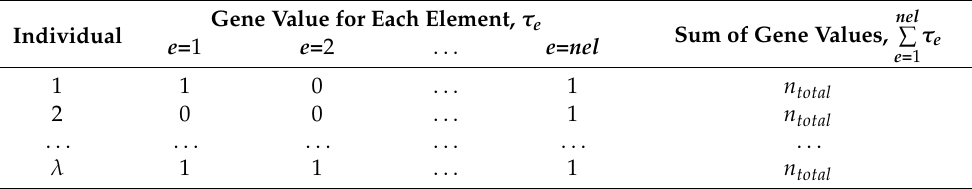
Table 1. Mechanical properties of the orthotropic and isotropic